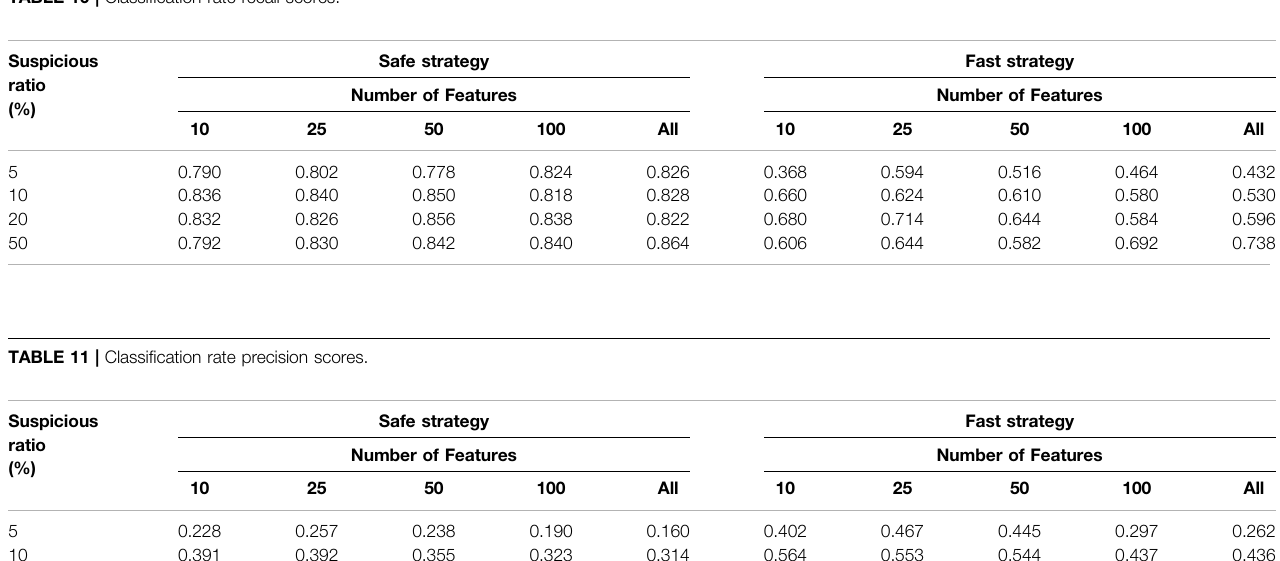
TABLE 10 | Classi fi cation rate recall scores.